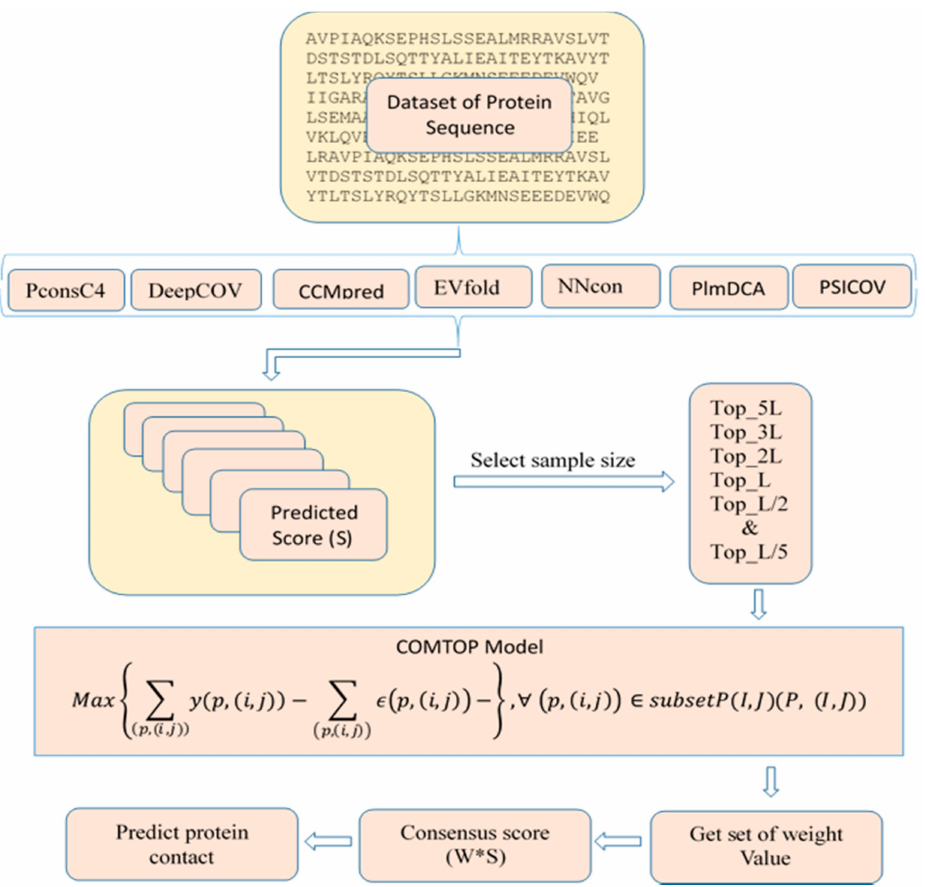
Figure 1. The workflow of COMTOP model for protein contact